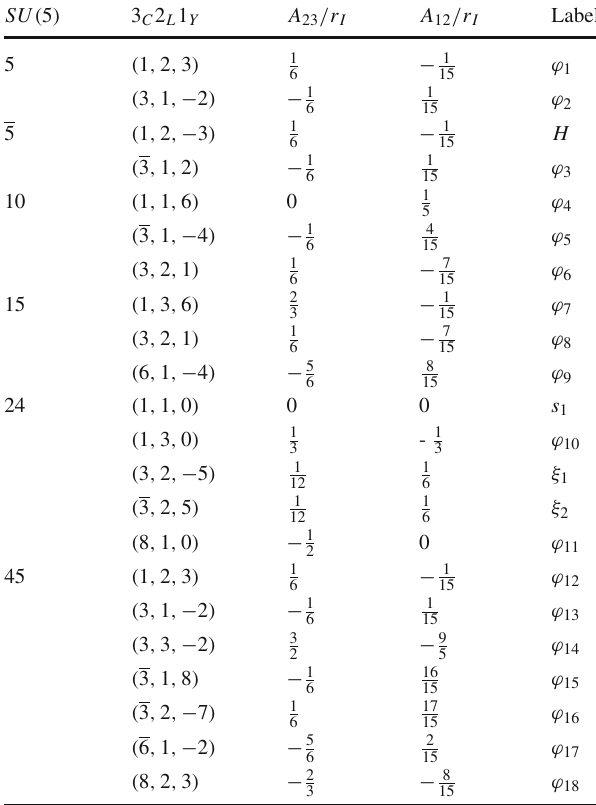
Table 1 Decomposition with respect to SU ( 3 ) C × SU ( 2 ) L × U ( 1 ) Y of the scalar representations in conservative SU ( 5 ) GUTs.